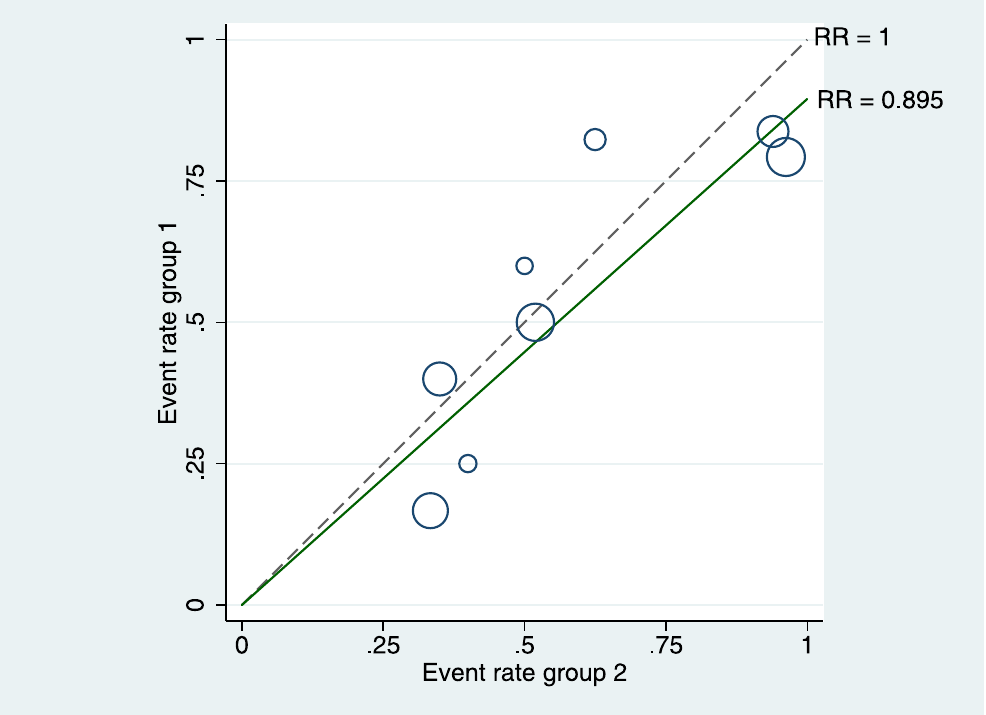
Fig 3. L’Abbe´ plot of bacteremia rates in the chlorhexidine and control groups. The symbol size represents the sample size. The dotted line represents the no-effect line with identical rates in both groups. The solid line corresponds to a pooled relative risk of 0.895. (RR) = Relative